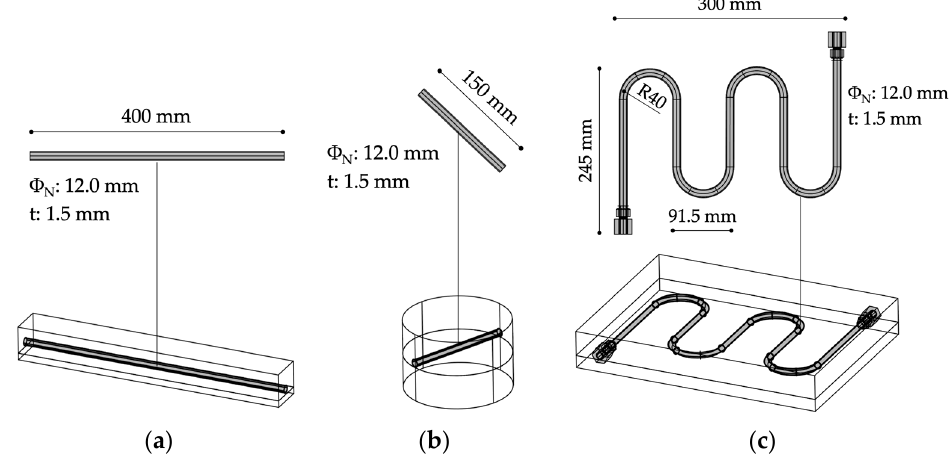
Figure 4. Details about the produced samples: example of PR ( a ), CY ( b ), and SL ( c ).